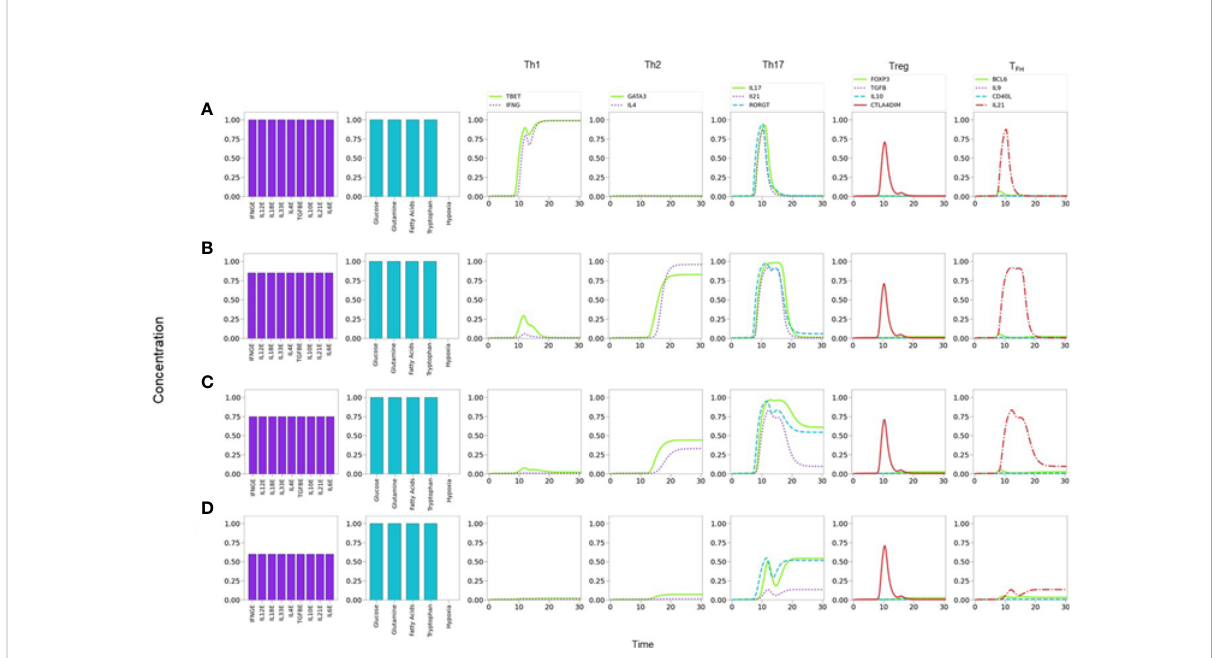
FIGURE 7 Phenotype expression in a microenvironment de fi ned by variable levels of a uniform mixture of all-type of exogenous cytokines, under optimal nutrient and normoxic conditions (as indicated in histograms). Denoting cytokine levels by CLs, we observe that (A) a maximal CL = 1.0 induces a Th1 polarization, with a transient Th17 expression. (B) A smaller CL = 0.80 shifts the polarization towards Th2, also including a transient Th17 response. (C) A further decrease to CL = 0.75conduces to a mixed Th2-Th17 phenotype. (D) At CL = 0.6, Th2 vanishes and only Th17 is expressed at a moderate value. Eventually, at an all-cytokine threshold level CL = 0.40 no phenotype expression arises (not shown), indicating cytokine insuf fi ciency to promote